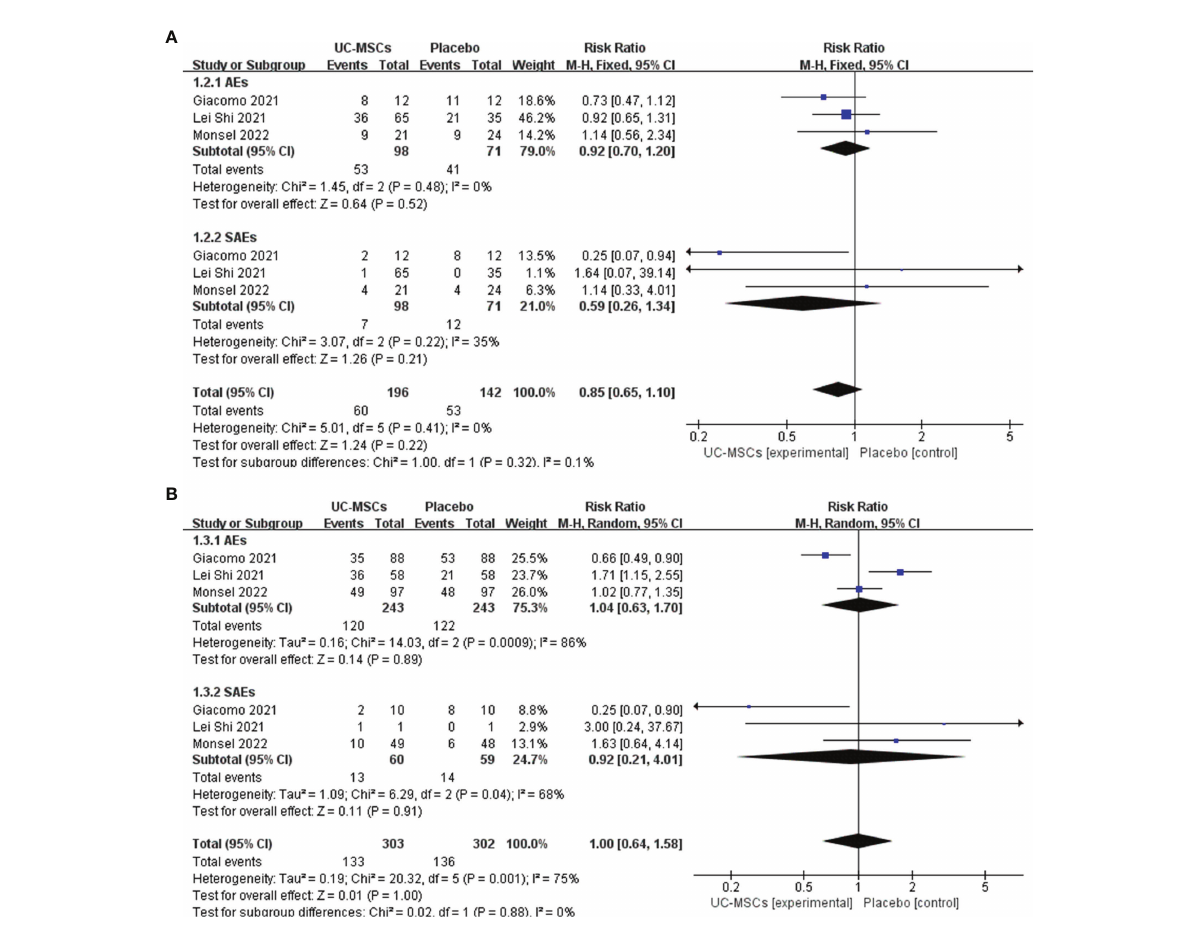
FIGURE 3 The effect of UC-MSCs therapy by forest plot diagram on AEs and SAEs. (A) The number of patients experiencing AEs and SAEs; (B) The number of types of AEs and